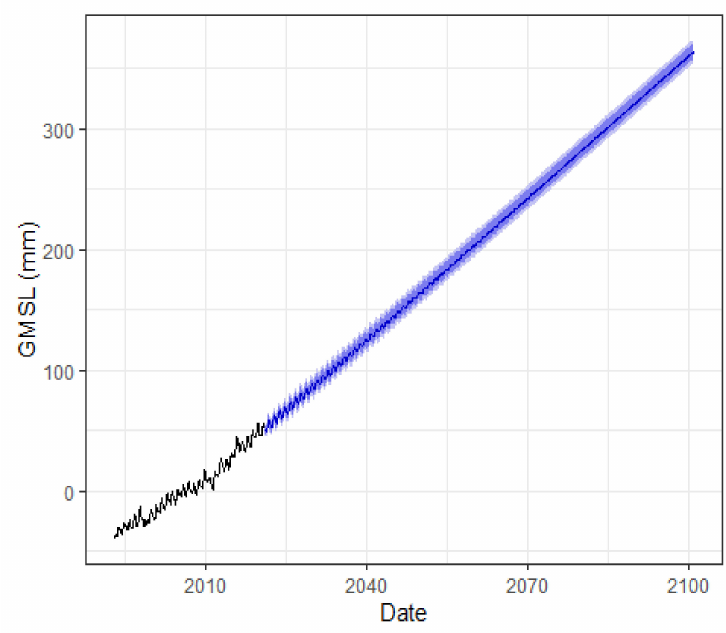
Figure 8. GMSL from 2021 to 2100 predicted by the VAR(3) model using the observed data (Jan- uary 1993–May 2021) with the 80% (darker blue area) and the 95% (lighter blue area) prediction interval bands.